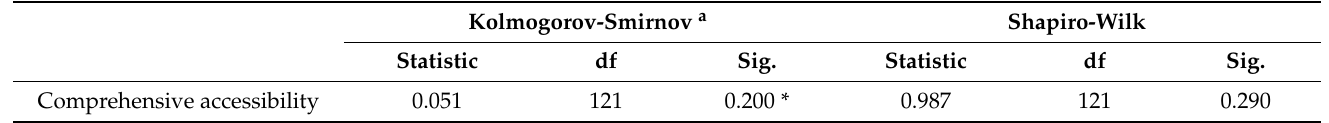
Table 4. Normality test of the comprehensive urban land accessibility of the sample population.